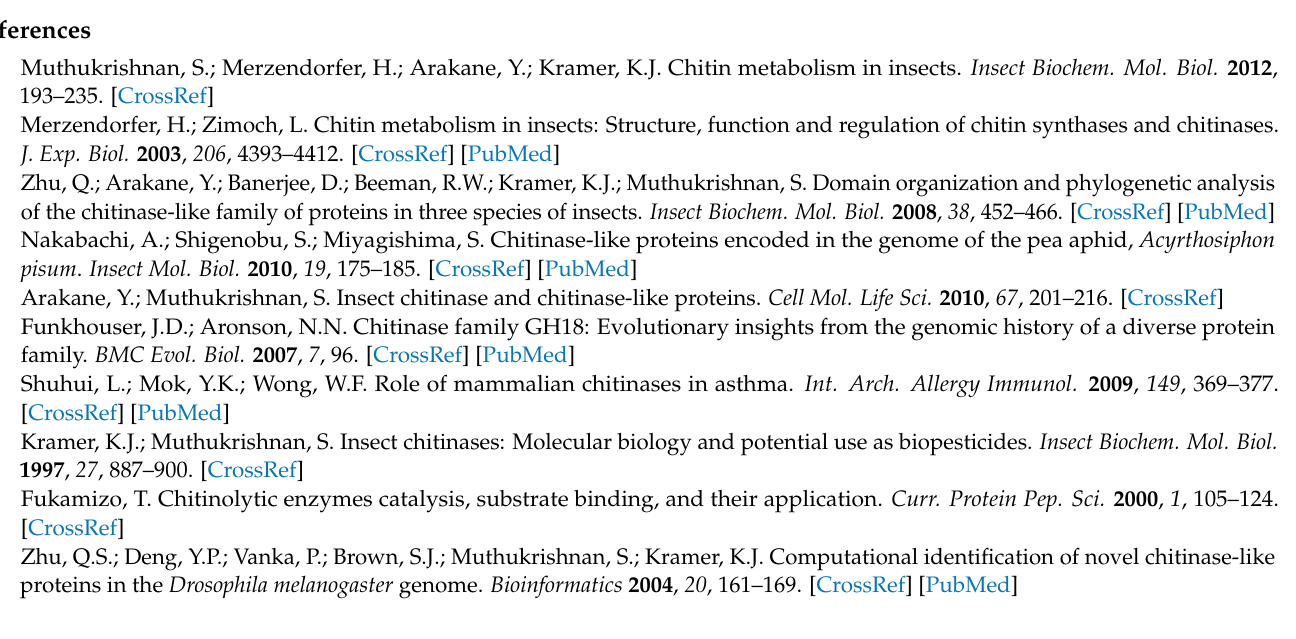
Table S3: Accession numbers of sequences used for phylogenetic